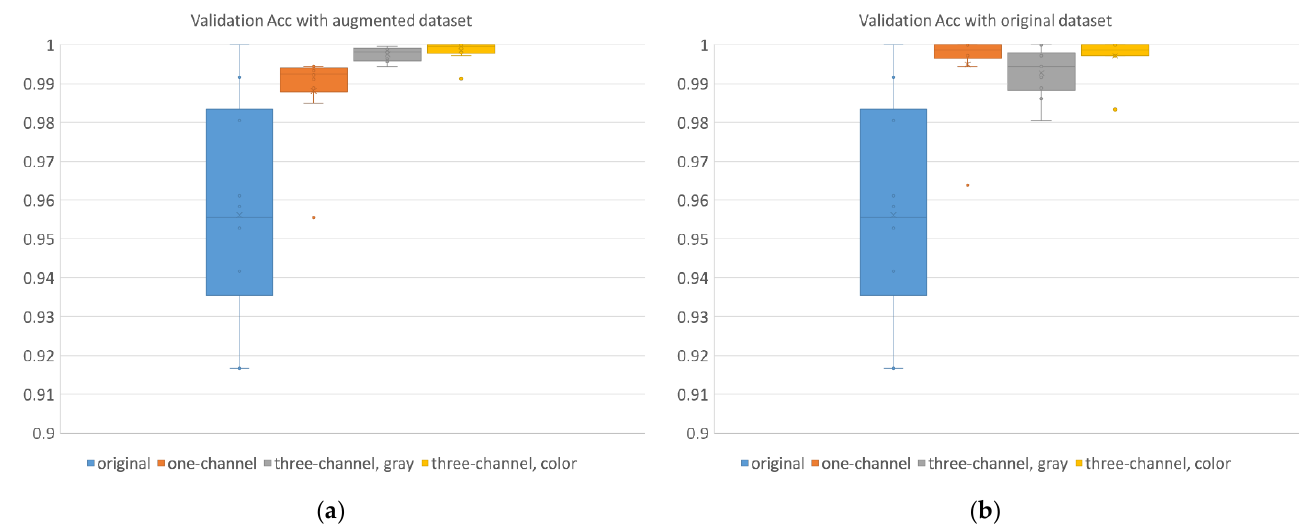
Figure 13. Boxplots of validation accuracy with Resnet18: ( a ) results validate with the augmented dataset; ( b ) results validate with the original dataset.